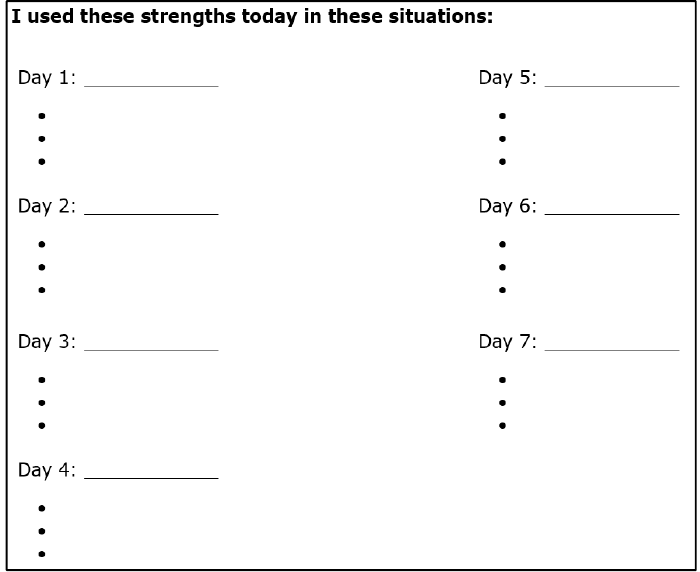
Figure A3. Worksheet for identifying strengths.